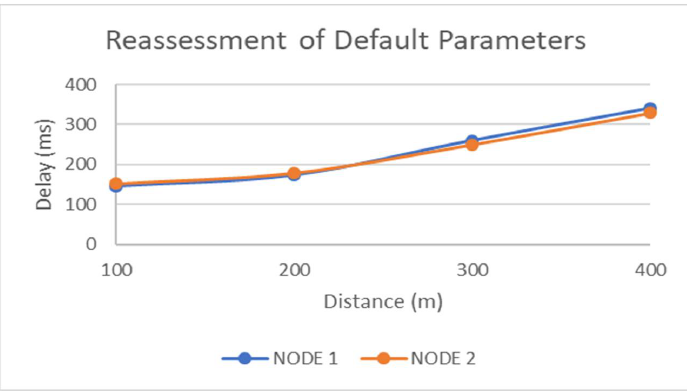
Table 5. The average value from the reassessment of several spreading factor parameters.